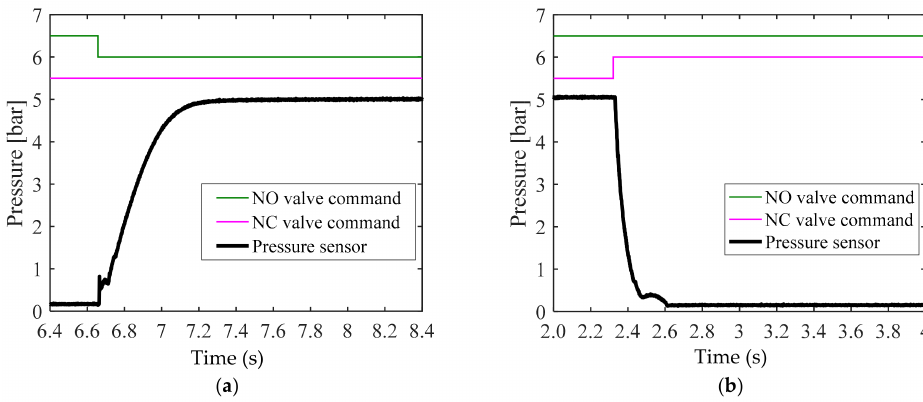
Figure 6. Experimental results for pneumatic valve’s response tests for the ( a ) apply mode test with